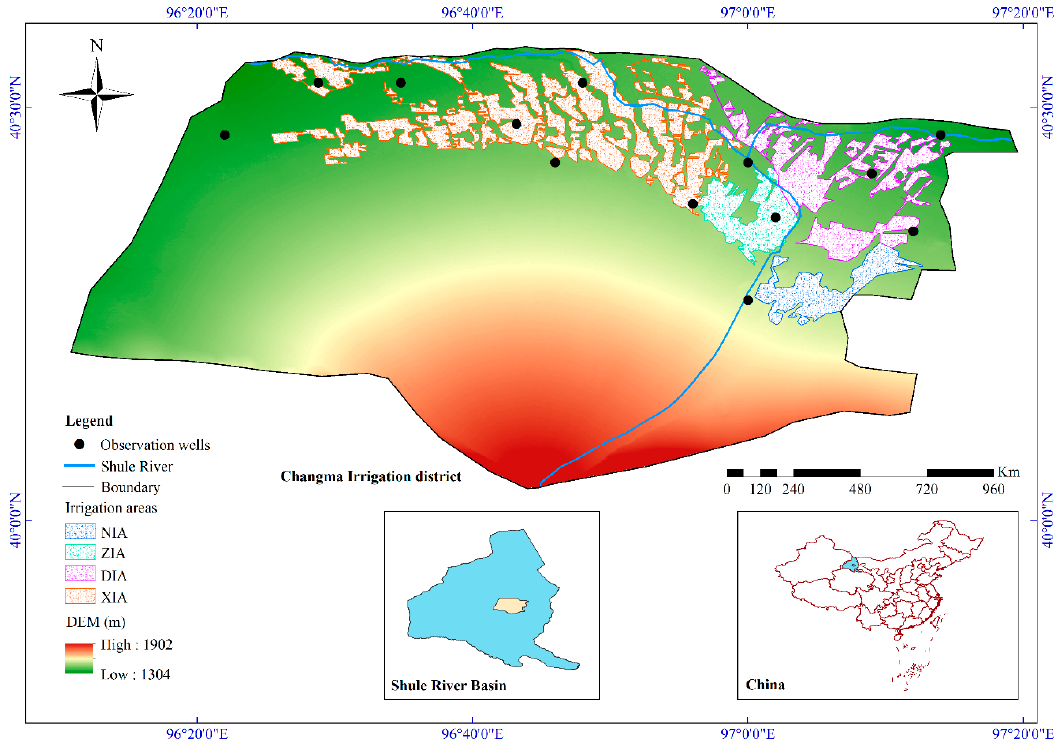
Figure 2. Geographical location, topography, and irrigation area of the study area.